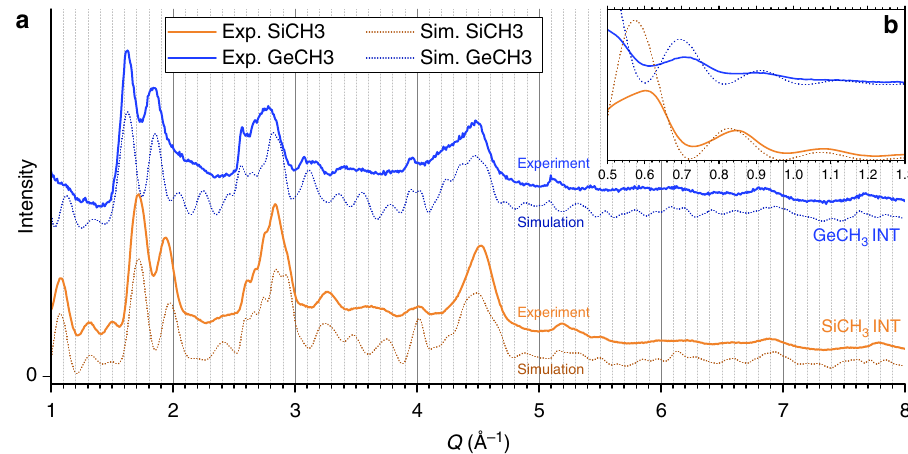
Fig. 5 Comparison between experimental and calculated WAXS diagrams. a WAXS diagrams of methylated Si/GeCH 3 INT powders and related simulations. b The inset displays lower wave-vector